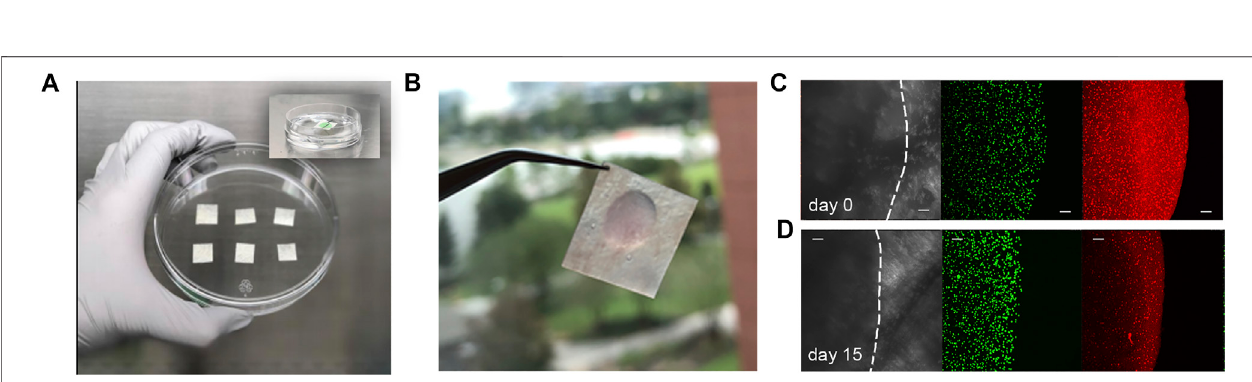
FIGURE2| Creatingthe3D-STprototype. (A) DynaMatrix ® membranecutintosmallsquaresforpilotstudy;inlaterversions,thesearecutcircularly. (B) Hydrogels attached stably to the SIS membrane. (C) Gelation of hydrogel with encapsulated fl uorescent green beads (10 μ m) and red beads (200 nm) to visualize hydrogel shape and position on the day of encapsulation and (D) after 15 days of mock feeds and handling. The bulk hydrogel and edges remained intact after 15 days. Scale bars (cid:1) 100 µm.